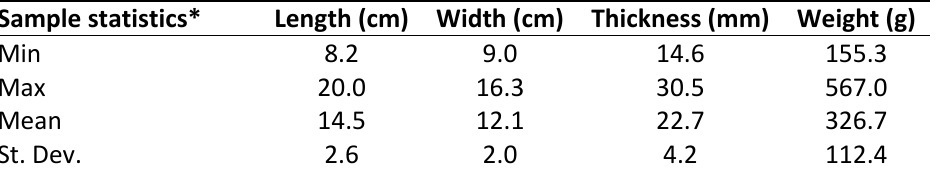
Table 1. Combined sample statistics for T-shaped axes in the Moyne-Feachem collection from the Bay Islands, Northeast Honduras (Cambridge University Museum of Archaeology and Anthropology). Incomplete specimens (marked by "?" for individual items in Table 2) are not included in the calculation of sample statistics. Sample statistics* Length (cm) Width (cm) Thickness (mm) Weight